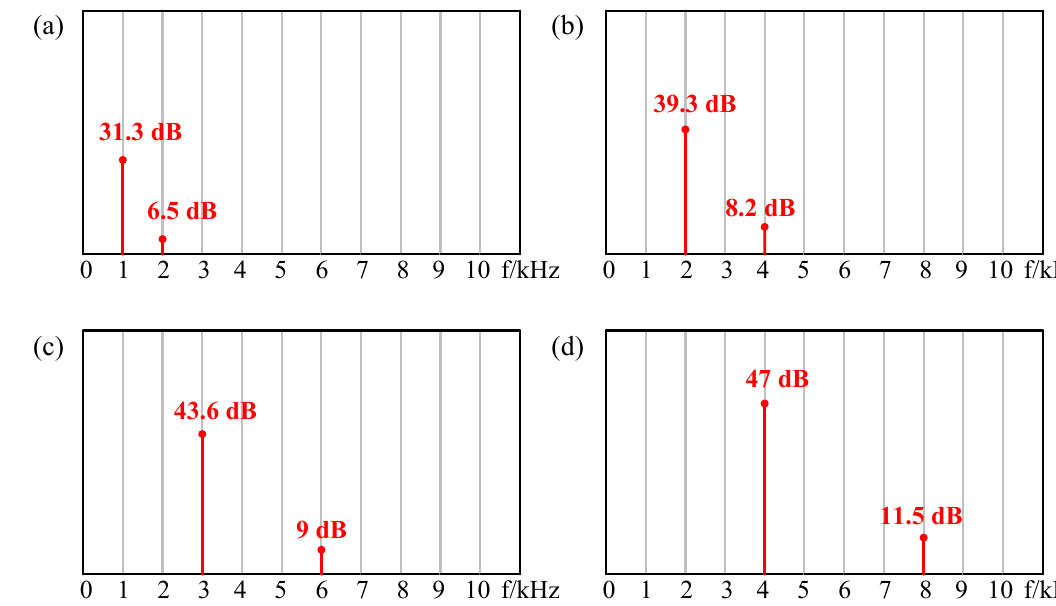
Figure 11. The results excited by DC equal to AC with frequency at ( a ) 1 kHz, ( b ) 2 kHz, ( c ) 3 kHz, ( d ) 4 kHz.